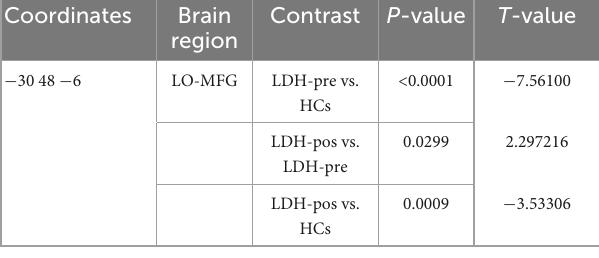
LO-MFG,theleftorbitalpartmiddlefrontalgyrus;LDH-pre,lumbardischerniationpatients before Tuina treatment; HCs, healthy controls; LDH-pos, lumbar disc herniation patients afterTuinatreatment. TABLE 5 Group differences in mean dFC variance values. Seed Connected region